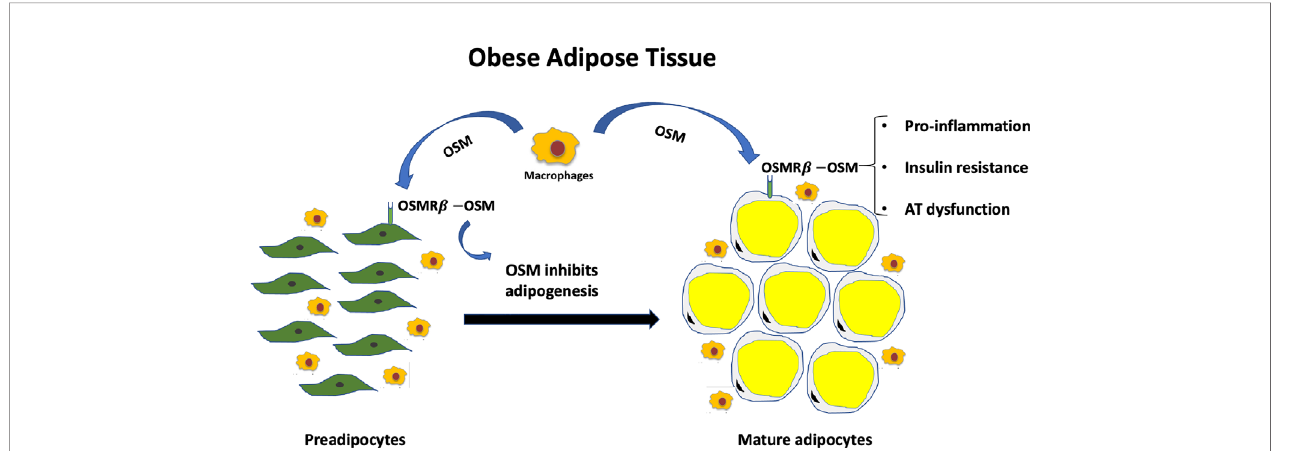
FIGURE 1 | Excess OSM and lack of adipocyte OSM signaling contributes to metabolic dysfunction. Less than half of the cells that comprise white adipose tissue depots are adipocytes. OSM is not produced in adipocytes, but in adipose tissue macrophages in conditions of obesity. OSM acts on preadipocytes to inhibit adipogenesis and acts on mature adipocytes to promote in fl ammatory signaling and insulin resistance in adipocytes. Both a loss of OSM signaling in adipocytes or excess OSM in adipose tissue promote systemic metabolic